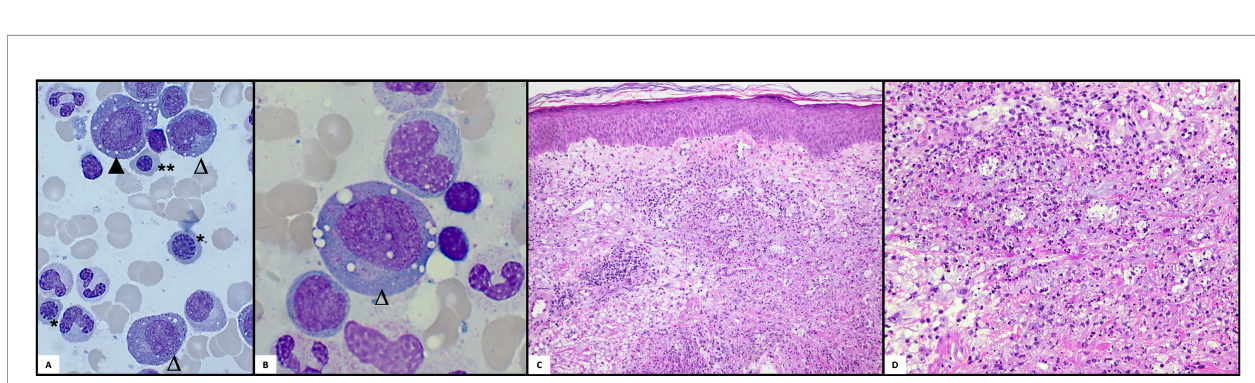
FIGURE 4 | Histologic examinations. (A) Bone marrow cytomorphology: Pappenheim staining of a bone marrow aspirate is shown with typical vacuolizations in erythroid ( ▲ ) and myeloid progenitors ( △ ). Moreover, megaloblastic (*) and macroblastic (**) changes can be seen in the normoblasts (light microscope Zeiss, x40 ). (B) Bone marrow cytomorphology: Higher magni fi cation of vacuolized myeloid progenitor (light microscope Zeiss, x100 ). (C, D) Histology of the skin: Neutrophilic dermatosis with neutrophilic perivascular and interstitial in fi ltrate with leukocytoclasia and few eosinophils involving the dermis.